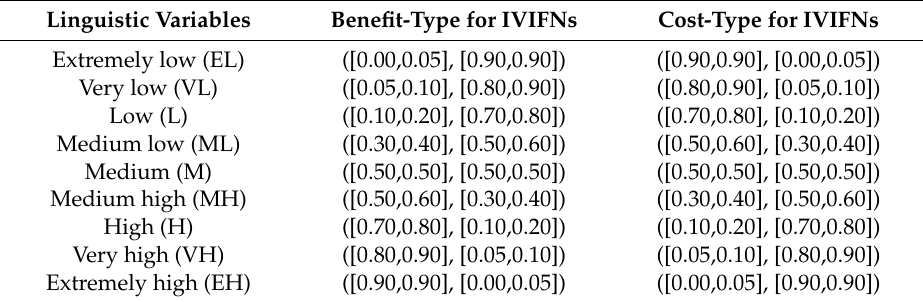
Table 1. Linguistic variables for rating failure